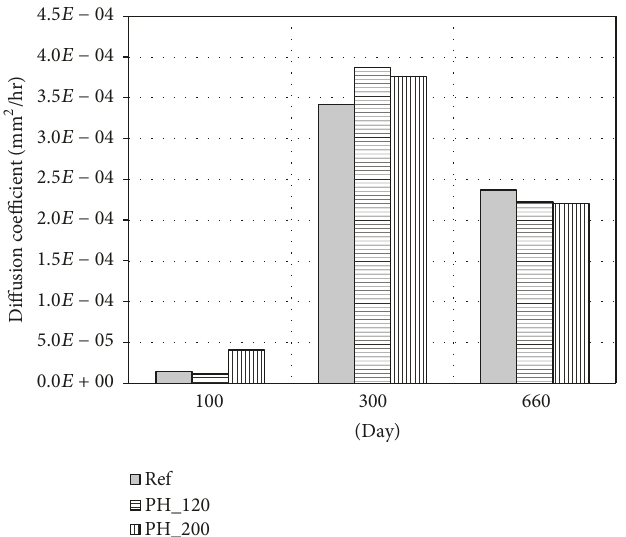
Figure 14: Alkaline solution diffusion coefficient